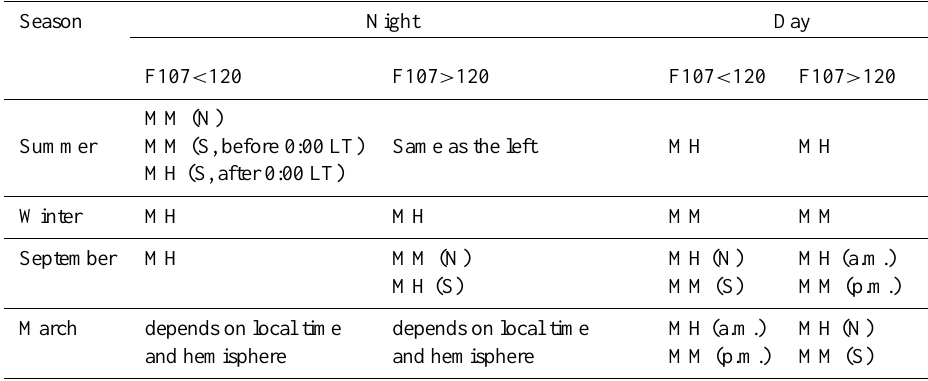
Table 2. The dependence of the two latitudinal trend on hemisphere, local time, season and solar activity*. Season